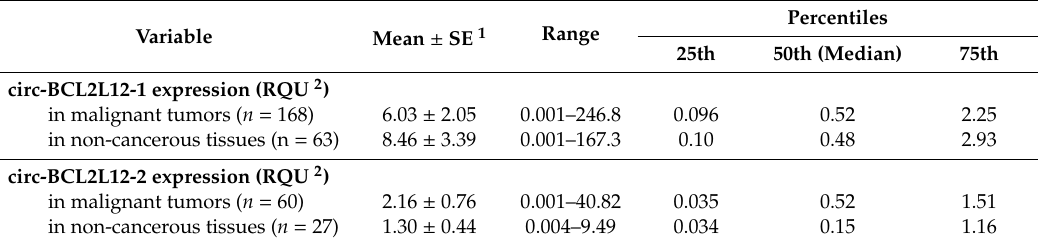
Table 3. Distributions of BCL2L12 circRNA expression levels in cancerous and non-cancerous tissue